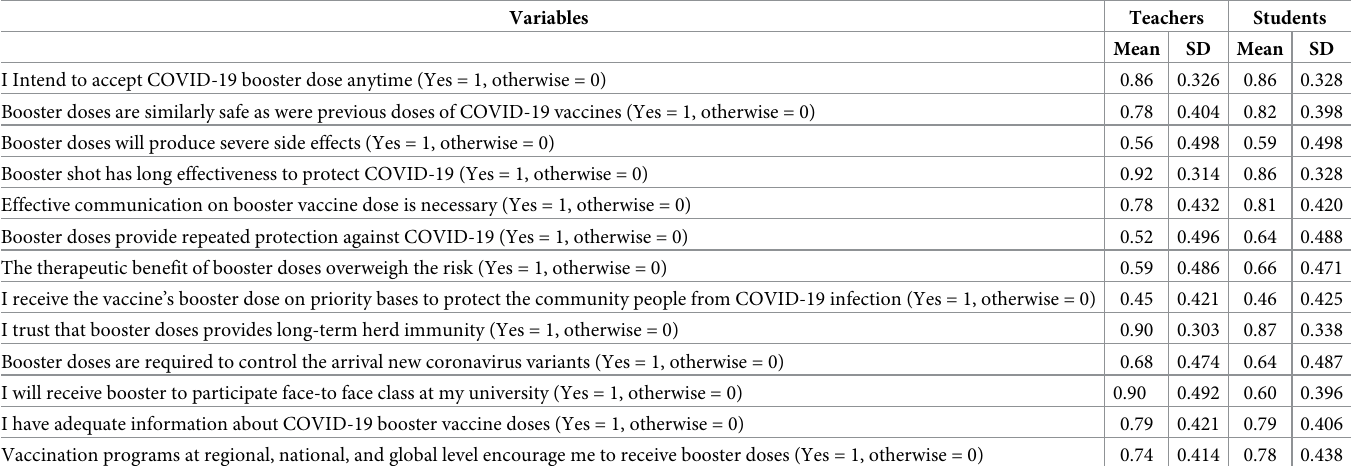
Table 2. Descriptive results of the variables.